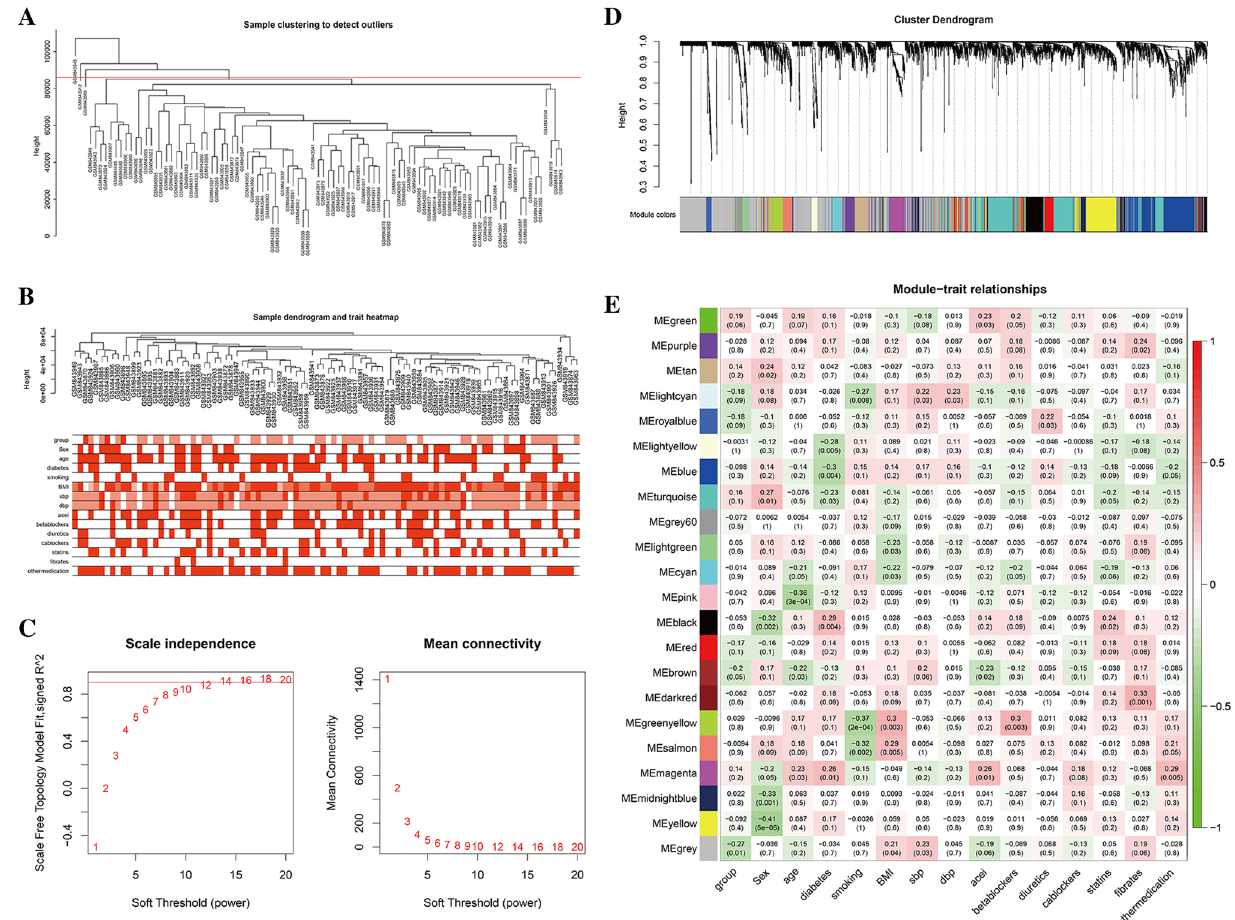
Figure 2. Drawing weighted gene co expression network of MI based on WGCNA package of R 3.5.1 software (https:// www.r- proje ct. org/). ( A ) Three outliers are removed from the hierarchical clustering graph. ( B ) Hierarchical clustering graph of samples. The orange in the figure represents the phenotype, and the color depth represents the value of the item. ( C ) Analysis of the scale-free fit index for various soft-thresholding powers (β), 12 was the most fit power value. ( D ) The cluster dendrogram of genes in GSE34198. Each branch in the figure represents one gene, and every color below represents one co-expression module. ( E ) Heat map of the relationship between the characteristic genes of modules and MI. Correlation coefficient along with P value in parenthesis underneath. Color-coded according to correlation coefficient (legend at